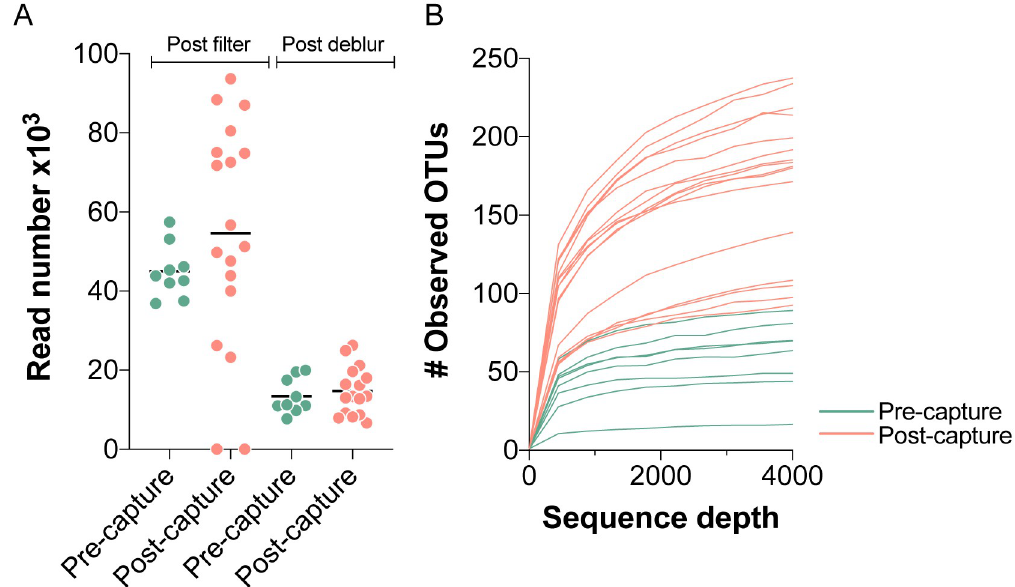
Fig 1. Number of sequencing reads and mapped OTUs in fecal bat samples. In A number of 16S rRNA V3-V4 gene reads passing read-trimming and quality filtering (post filter) and reads passing denoising (post Deblur) for bat fecal samples collected prior to capture (green) and post-capture (light-red) are shown for individual bats in a scatter plot. In B the number of observed OTUs recovered from data rarefied at a sequence depth of up to 4000 sequences are shown for each pre-capture and post-capture